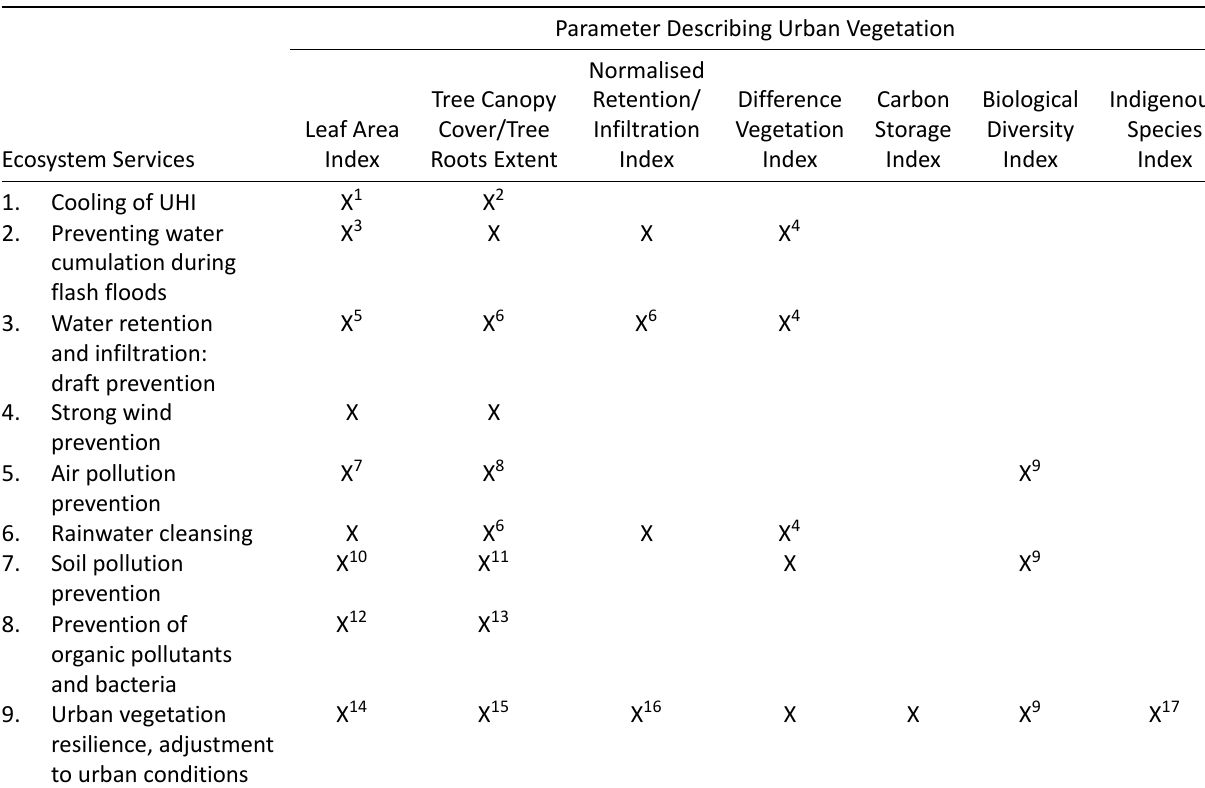
Table 1. Parameters of urban vegetation in relation to the role of greenery as a factor affecting comfort and climate